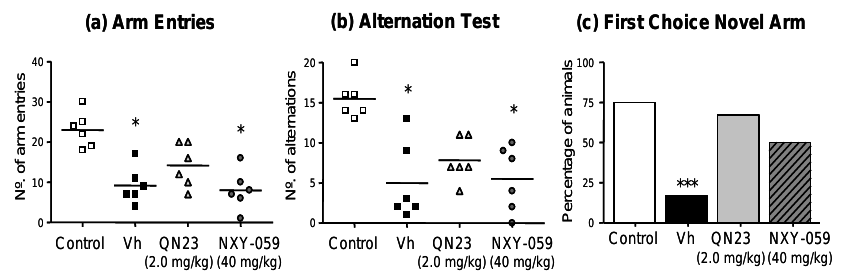
Figure 8. Study of the long-term effect of QN23 after cerebral ischemia–reperfusion by behavioral tests. Graphic representations of the results of three tests assessing the spatial recognition and spatial memory, as long-term cognitive sequelae, of control, vehicle-, QN23-, and NXY-059-treated animals 11 weeks after post-ischemic reperfusion. In ( a , b ), individual values of 6 independent animals per group are shown and the horizontal line represents the mean. * p < 0.05, compared with the control group by Dunn’s post-test after the non-parametric Kruskal–Wallis test, *** p < 0.001, compared with the vehicle (Vh) group by Fisher’s test. In ( c ), two animals of the control group had a null test.